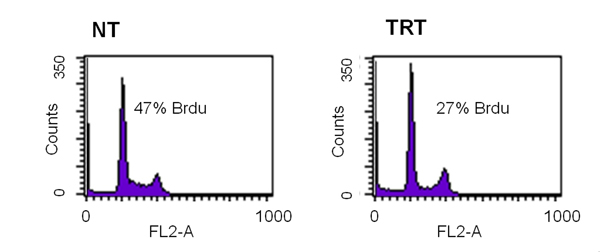
FACS analysis. A2780 cells were left untreated (NT) or treated for 6 hours with a cell cycle inhibitor (TRT). BrdU was added 30 min before harvesting and samples were processed for cell cycle analysis and BrdU incorporation analysis.